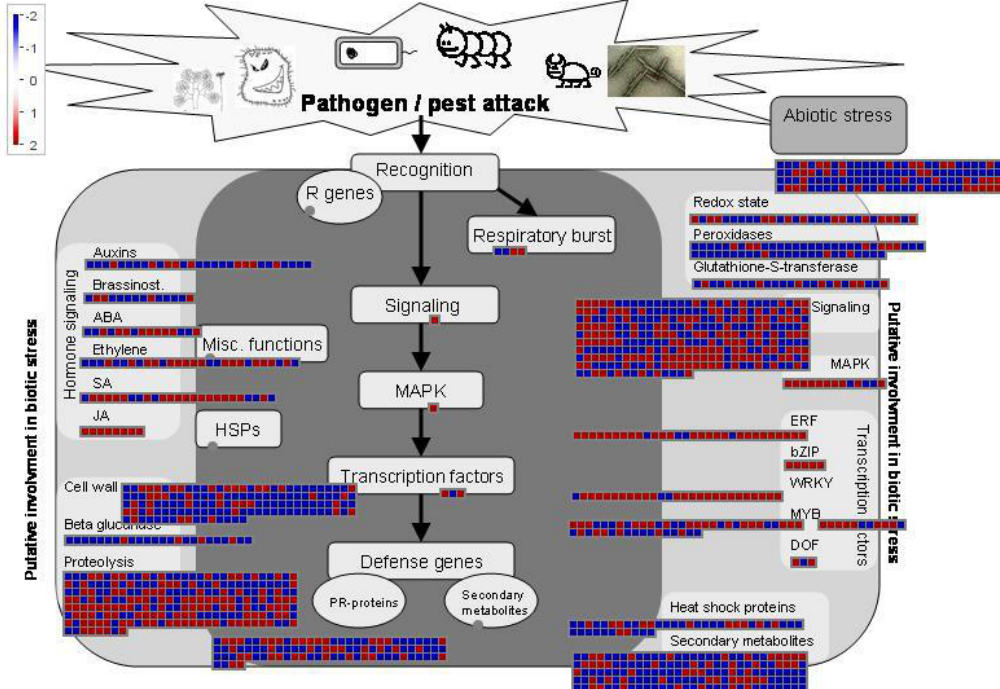
Figure 7. The model of the regulation mechanism of rice seedling root response to cold stress involves numerous pathways. DEGs involving these pathways are represented by small squares. The color of the small square reflects the change of DEGs after cold treatment at 5 ◦ C. Red / blue indicates that gene expression was induced / repressed compared with the control. Detailed information about all DEGs and pathways can be obtained in Table S5.